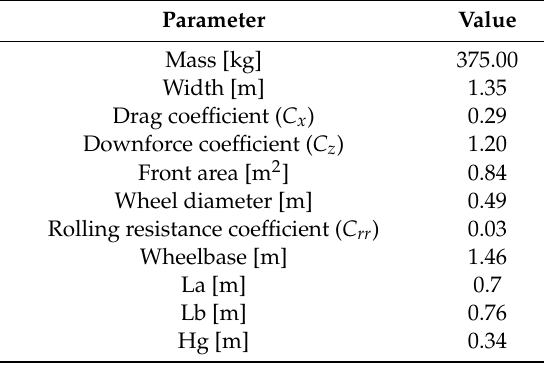
Table 1. Aerodynamic parameters of ISEC’s race